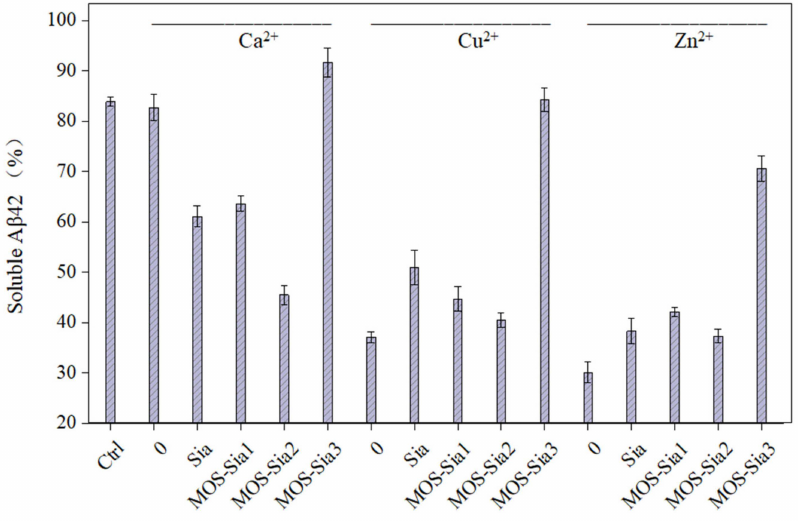
Figure 2. Residual soluble A β in supernatant after interaction with MOS-Sia, metal ion, and A β 42. Note: Molar ratio of A β 42 to metal ion was set as 1:1, with incubation for 24 h. Data are shown as the mean ± SD of triplicates.